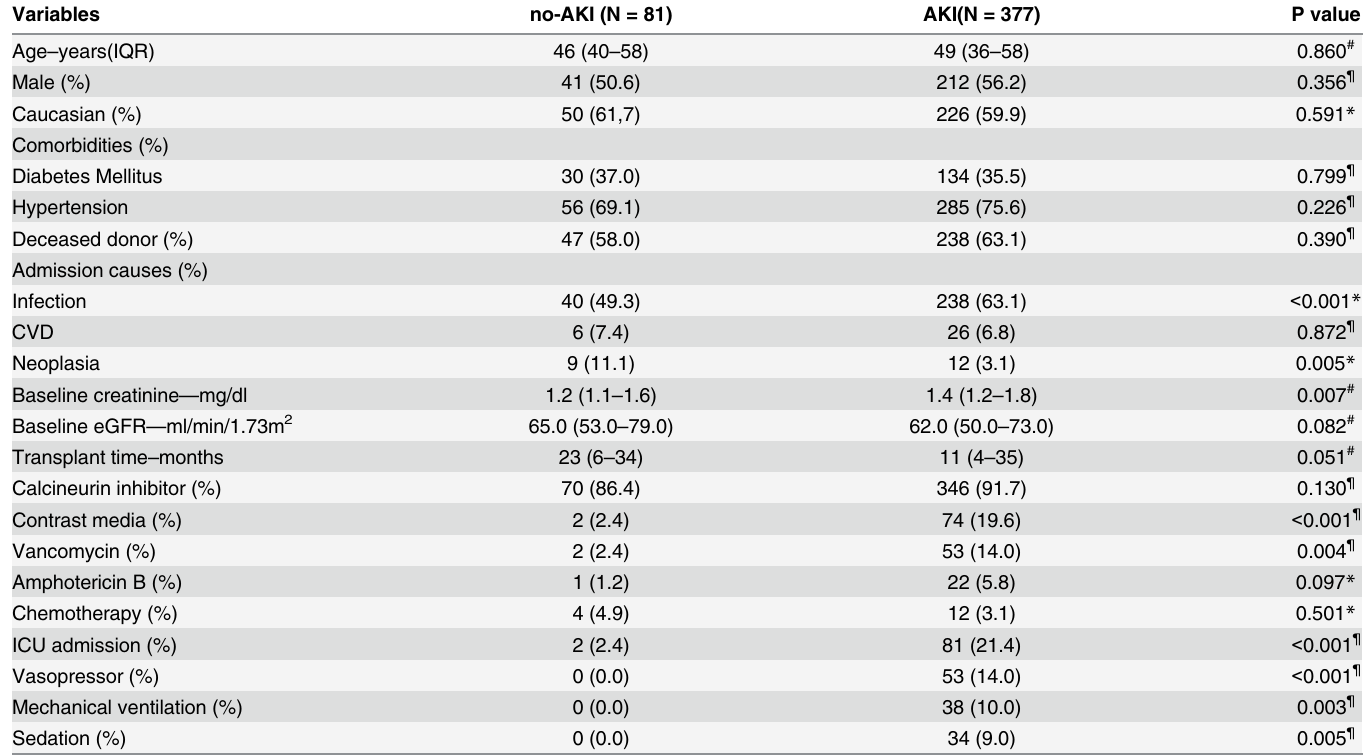
Table 1. Demographic and clinical